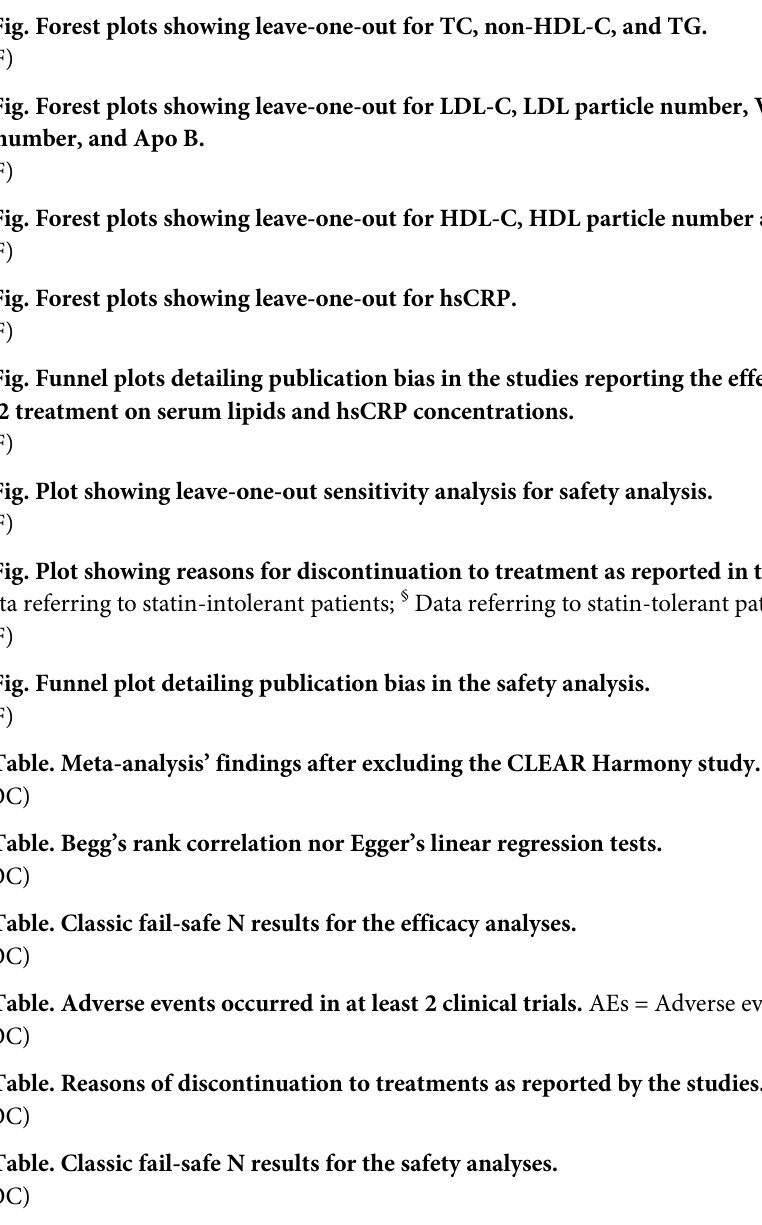
S6 Fig. Plot showing leave-one-out sensitivity analysis for safety analysis. S7 Fig. Plot showing reasons for discontinuation to treatment as reported in the studies.